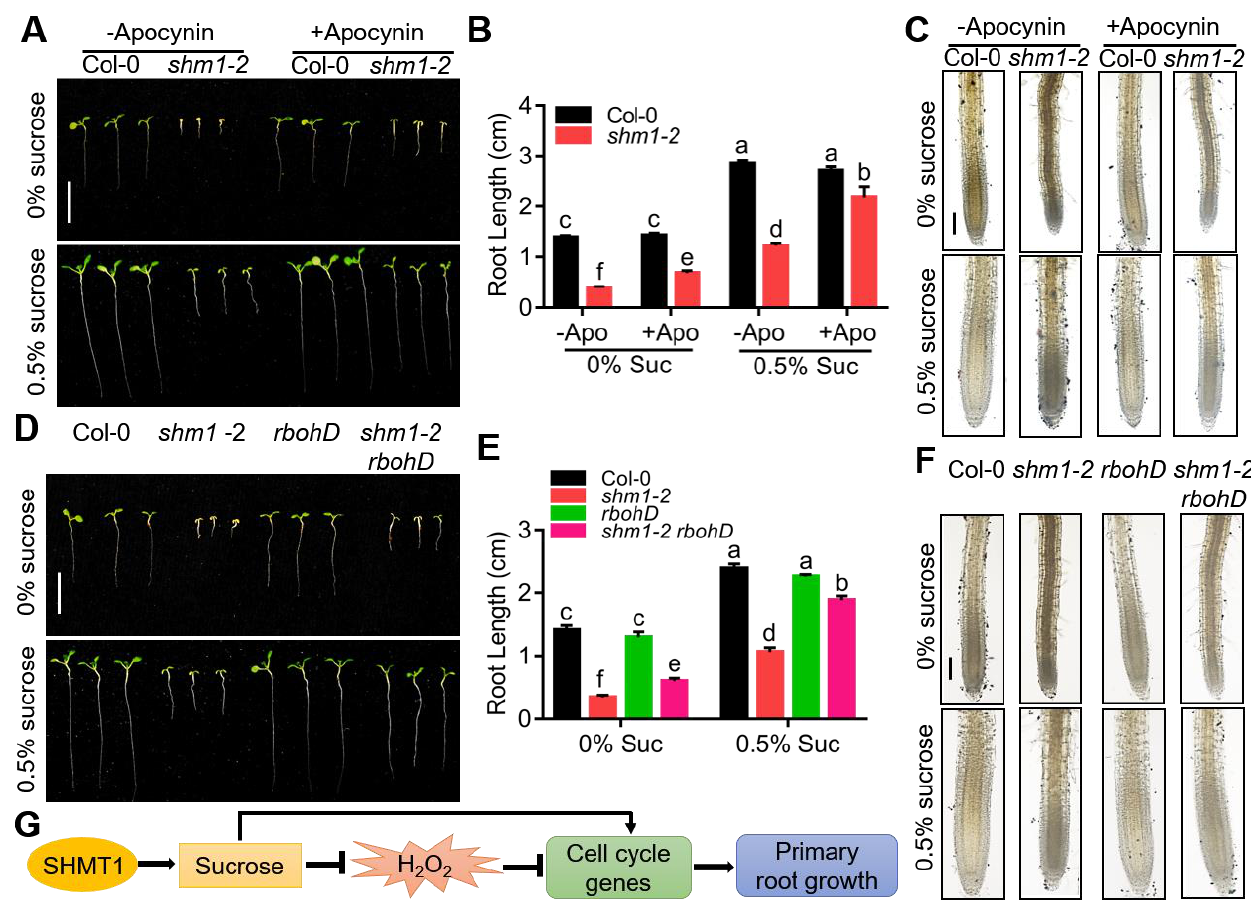
Figure 7. Application of NADPH oxidase inhibitor or mutation of RBOHD partially restored the root-arrest phenotype of shm1-2 at low-sucrose conditions. ( A ) The primary-root-growth phenotype of Col-0 and shm1-2 at low-sucrose conditions plus 10 µ M apocynin (NADPH oxidase inhibitor) or not for 8 days. Bars = 1 cm. ( B ) Primary-root length was statistically analyzed, as shown in ( A ). ( C ) DAB staining for H 2 O 2 in the primary roots of 8-day-old Col-0 and shm1-2 at low-sucrose conditions plus 10 µ M apocynin or not. Bars = 200 µ m. ( D , E ) The primary-root-growth morphology ( D ) and root length ( E ) of Col-0, shm1-2 , rbohD and shm1-2 rbohD at low-sucrose conditions for 8 days. Bars = 1 cm. ( F ) DAB staining for H 2 O 2 in primary roots of 8-day-old Col-0, shm1-2 , rbohD , and shm1-2 rbohD at low-sucrose conditions. Different letters above error bars indicate significant differences at p < 0.05, using two-way ANOVA with Tukey’s test. Bars = 200 µ m. ( G ) A proposed model for SHMT1 in primary-root-growth regulation. SHMT1 in roots promotes the accumulation of sucrose to inhibit H 2 O 2 accumulation; the reduced H 2 O 2 level then activates expression of cell-cycle genes and increases root-meristem activity, thereby promoting primary-root growth. The increased sucrose may also directly increase the expression of cell-cycle genes to promote primary-root growth.